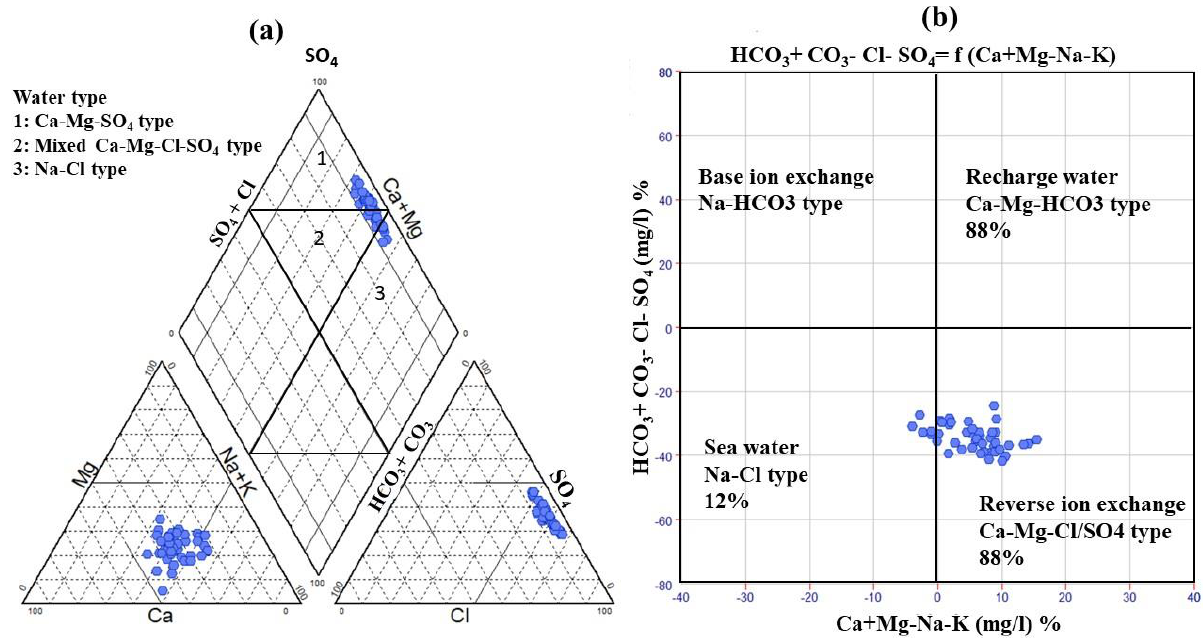
Figure 5. Graphical representation of the hydrochemical facies and the mechanism controlling the water chemistry: ( a ) Piper diagram; ( b ) Chadha water chemistry: ( a ) Piper diagram; ( b ) Chadha diagram.